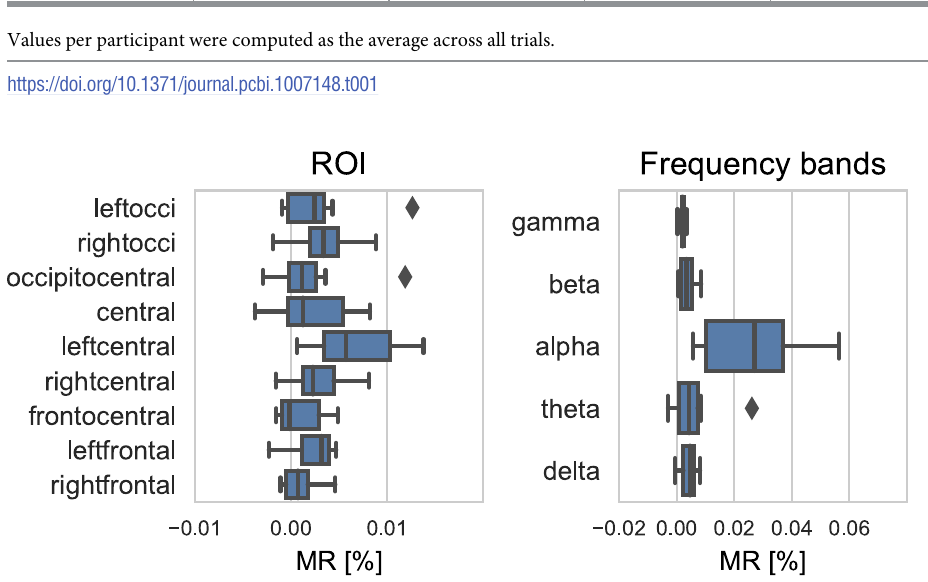
Fig 2. Grouped model reliances. Box-whisker plots of average grouped model reliance (MR) per participant for different ROI’s (left) and frequency bands (right) using a random forest